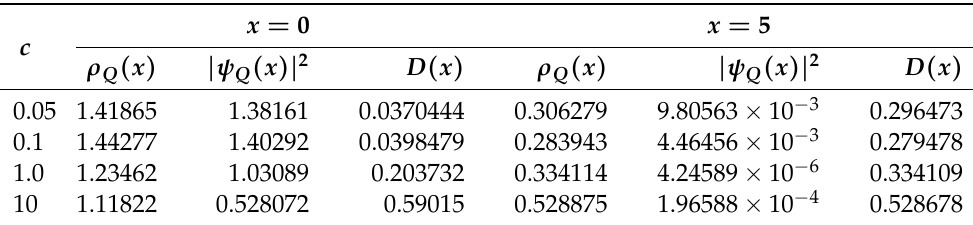
Figure 15. Density profiles (red curves) and the profiles of the square amplitude of the matrix element of the field operator between the quantum soliton states with N and N − 1 particles (blue curves) for N = L = 20 and the coupling constant c = 0.05,0.1,1.0, and 100. The vertical axis represents the local density. The quantum soliton state with the ideal Gaussian weights for all plots are given by ( P 0 , σ ) = ( 0.124027 π ,0.106667 ) and ( P (cid:48) , σ (cid:48) ) = ( π ,0.421637 ) , which are calculated by 0 Equations (93) and (94). Table 5. The values of the density profile ρ Q ( x ) , those of the square amplitudes | ψ Q ( x ) | 2 , and their differences D ( x ) at x = 0 and x =